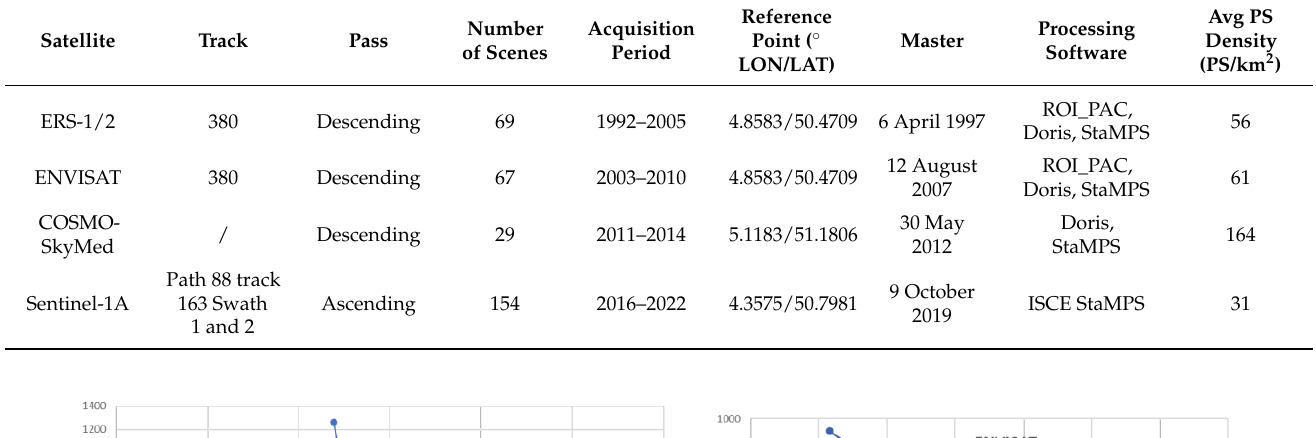
Table 1. Characteristics of the SAR-image datasets used in the ROI.